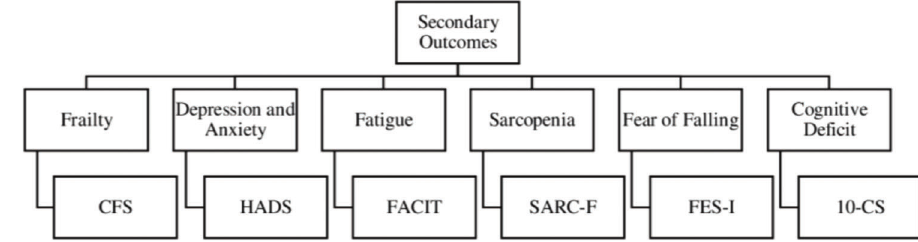
Figure 4 - Secondary outcomes that impact